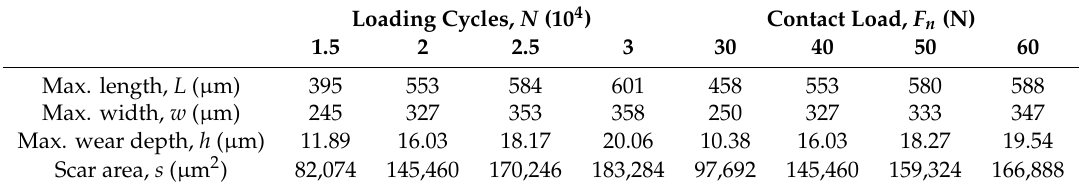
Figure 12. Top and front views of wear scars of cyclic loaded wires at different tension–torsion cyclic loading parameters.( a , b ) Effects of loading cycles; ( c ) and Figure 7c in reference [3] effect of contact load; ( d ) and Figure 7d in reference [3] effect of torsion angle; ( e ) and Figure 7b in reference [3] effect of crossing angle. Table 7. Dimensions of wear scars of cyclic loaded wires at different loading cycles and contact loads.